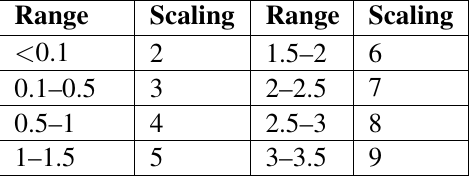
Table 2 Index layer scale comparison table